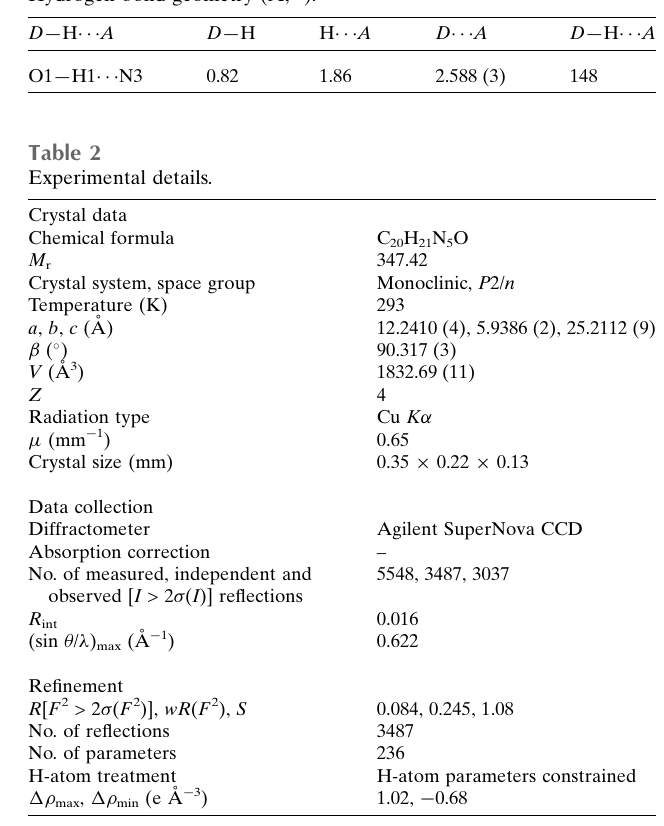
Table 1 Hydrogen-bond geometry (A˚ , (cid:2) ).